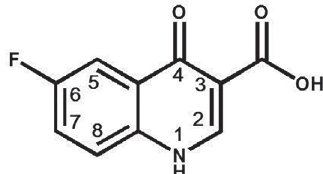
FIGURE 1 - Basic chemical structure of